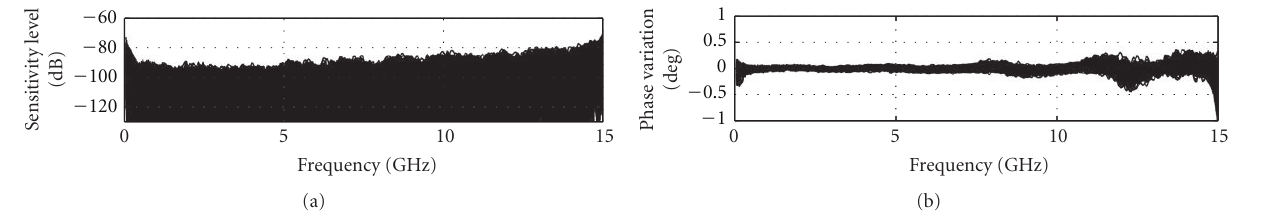
Figure 5: Sensitivity calculated based on a pair of 200 static measurements (no change of position) with a broadband load instead of the antenna. Measurement pairs are separated in time by 30 minutes to reproduce the time frame of two consecutive full TSAR scans.